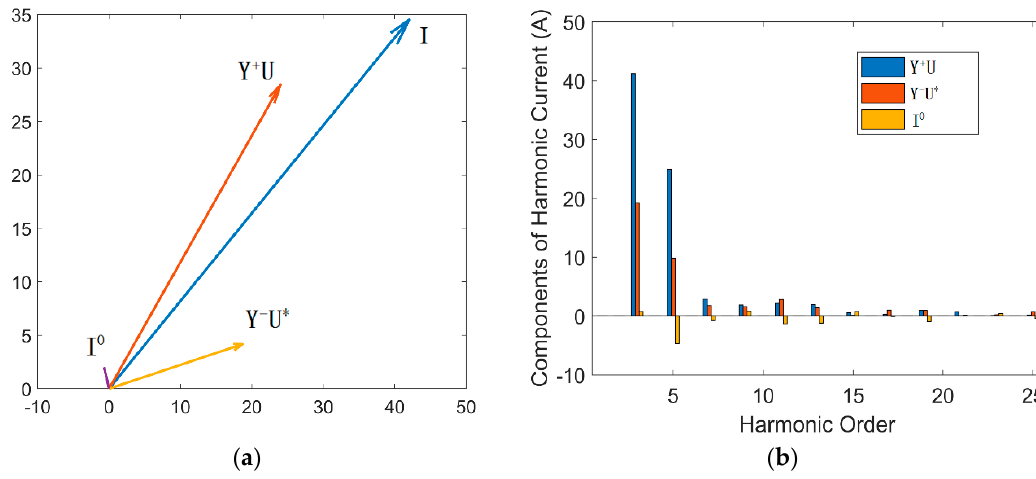
+ − ( a ) and Y ( b ), with unit Ohms.